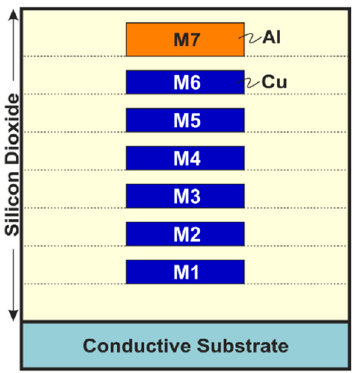
Figure 5. The 65-nm CMOS technology stack used in this work. Inductor windings are routed using M7 metal layer, whereas layer M6 is used for undercrossing (M7 and M6 are connected with vias).